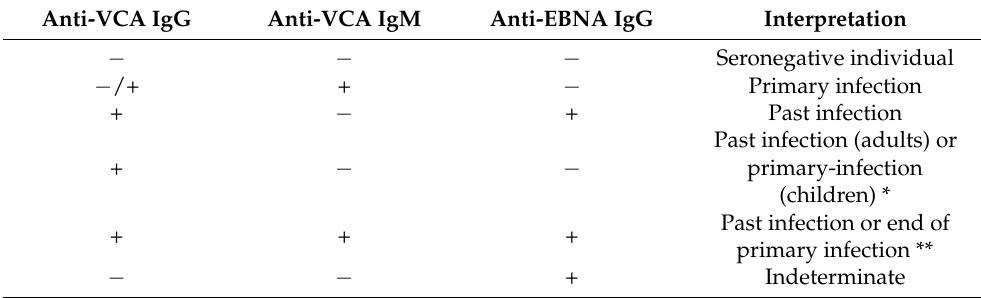
Table 2. Main Epstein–Barr virus serological